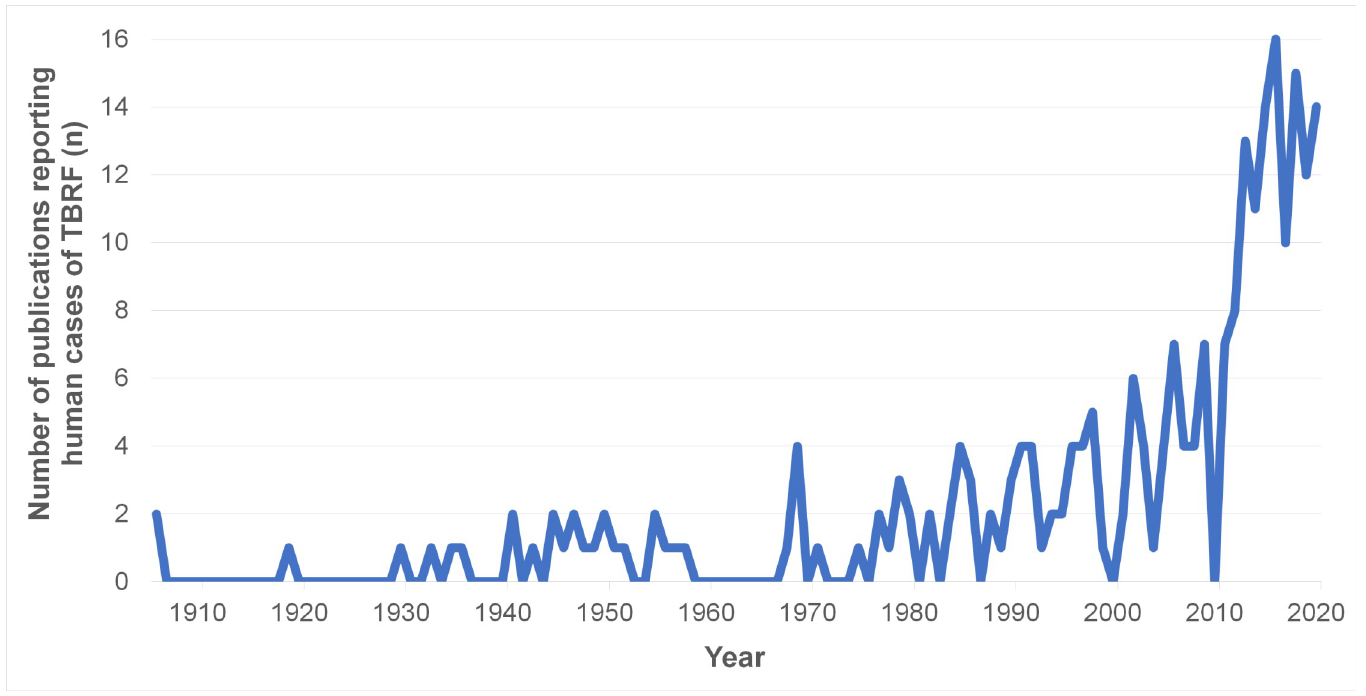
Fig 4. Number of TBRF case studies published from 1906 to 2020. TBRF, tick borne relapsing fever.